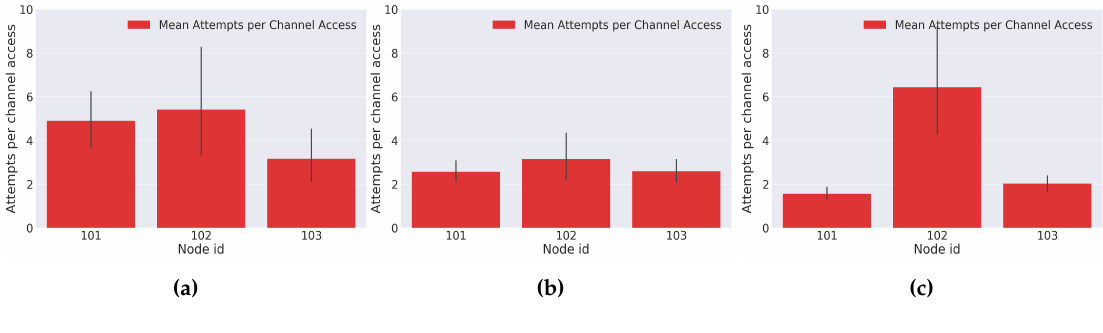
Figure 15. LoRa’s mean attempts per channel access ( a ) Day 1; ( b ) Day 2; ( c ) Day